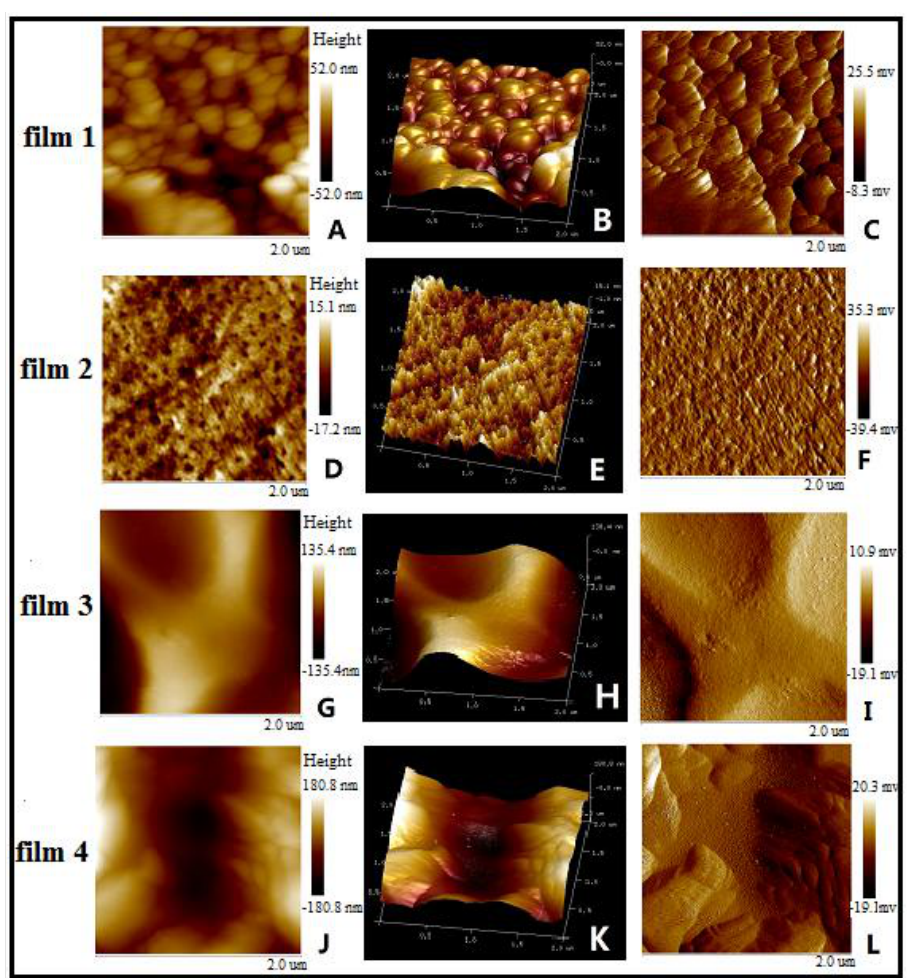
Figure 6. AFM height images ( A , D , G , J ), 3D topography ( B , E , H , K ), and phase topography ( C , F , I , L ) of the blend Film 1, Film 2, Film 3, and Film 4.